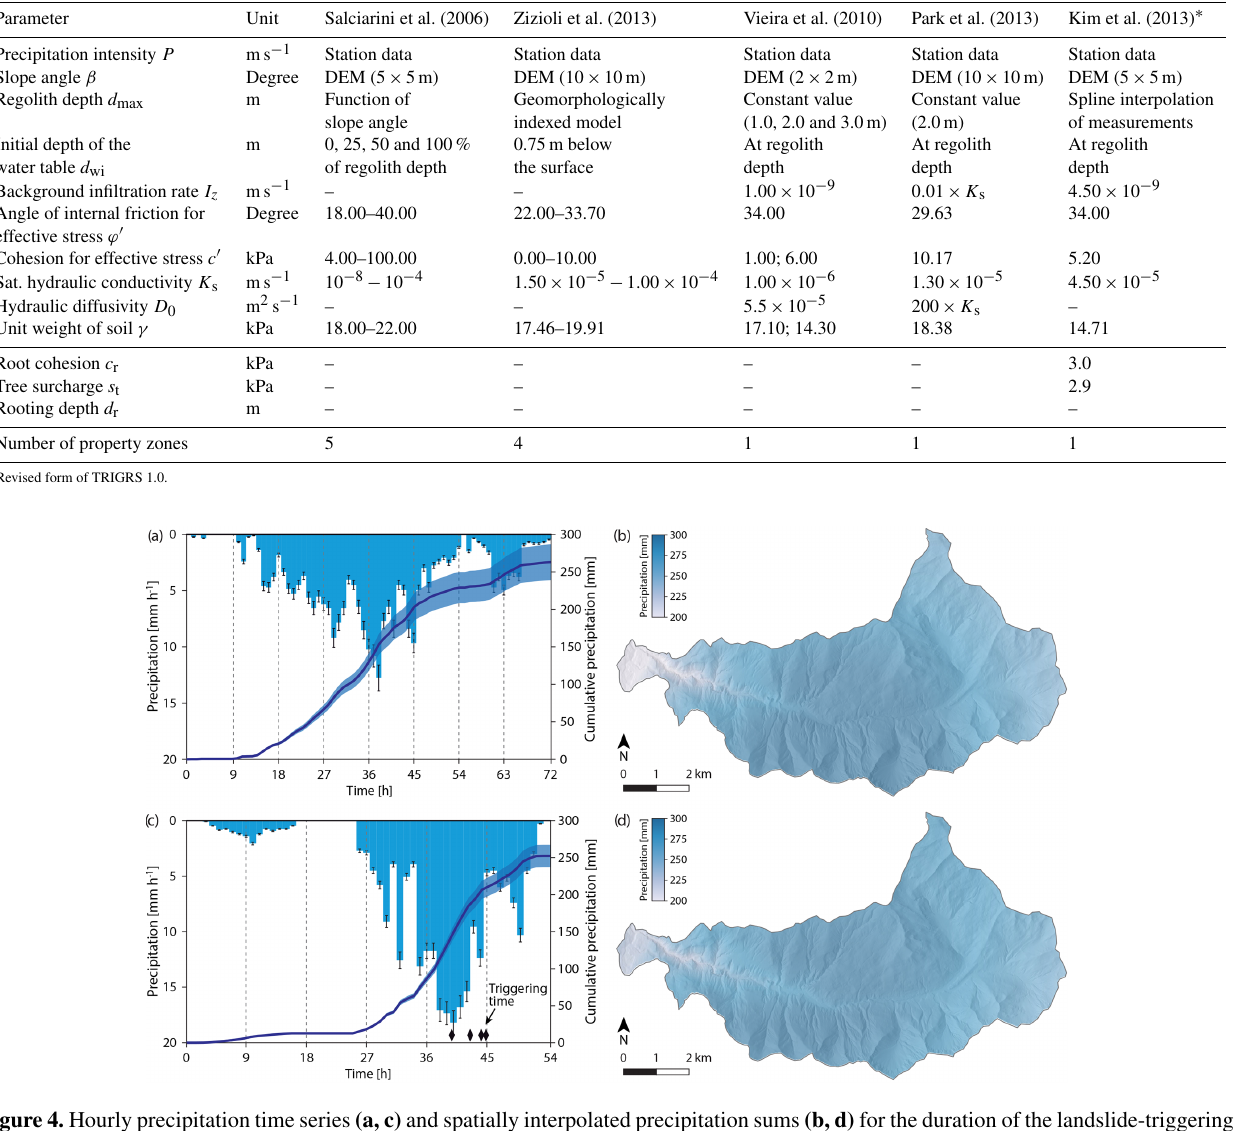
Figure 4. Hourly precipitation time series (a, c) and spatially interpolated precipitation sums (b, d) for the duration of the landslide-triggering rainfall events in 1999 ( a , b ; 07:00 on 20 May to 07:00 on 23 May) and 2005 ( c , d ; 07:00 on 21 August to 12:00 on 23 August). The error bars and the shading for the cumulative precipitation sum in (a) and (c) indicate the range of the interpolated hourly precipitation sums within the catchment